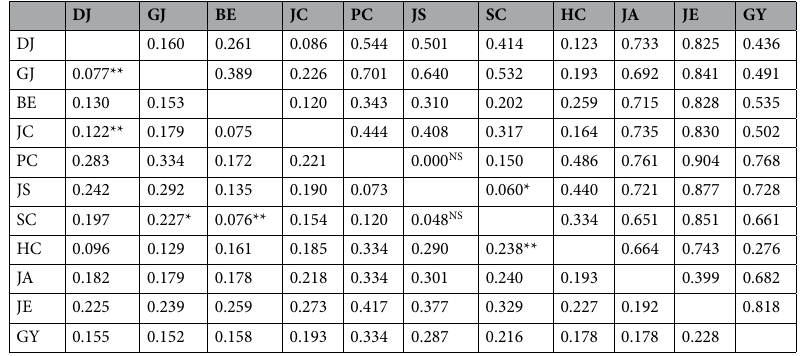
Table 3. Pairwise genetic differentiation among 11 Karsenia koreana populations estimated from microsatellite data. Population codes follow Table 1. Estimates of R ST and F ST appear above and below the diagonal, respectively. All estimated values significantly deviated from zero ( p < 0.001) except those denoted by **( p < 0.01), *( p < 0.05) and ’NS’.